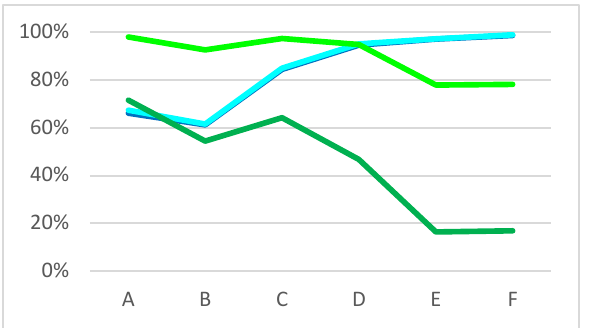
Figure 13. F1-Score